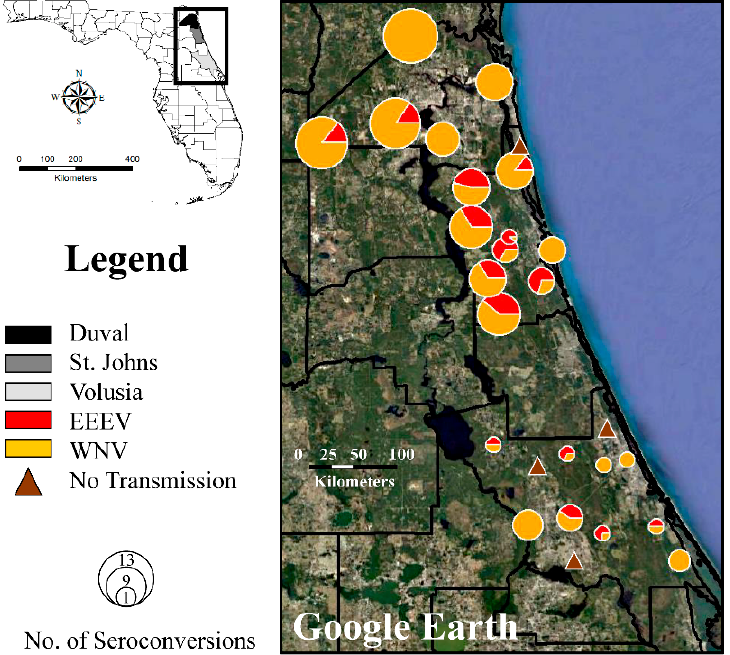
Figure 1. Proportion and abundances of 2018 EEEV- and WNV-positive seroconversions at sentinel chicken coops across the study area.